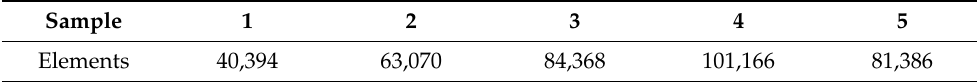
Table 1. Number of tetrahedral elements in the finite-element model of the vocal